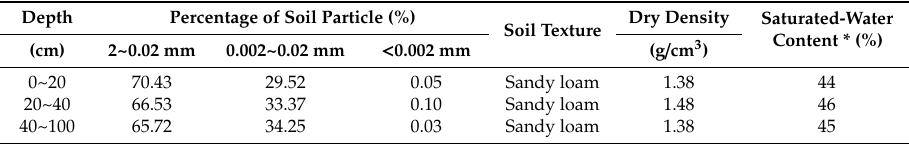
Table 1. Soil physical properties in the experimental area.